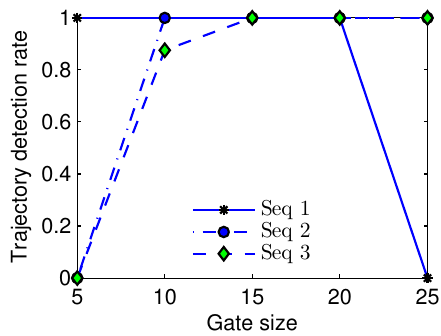
Figure 6. Relationship curve of the trajectory detection rate and gate size.